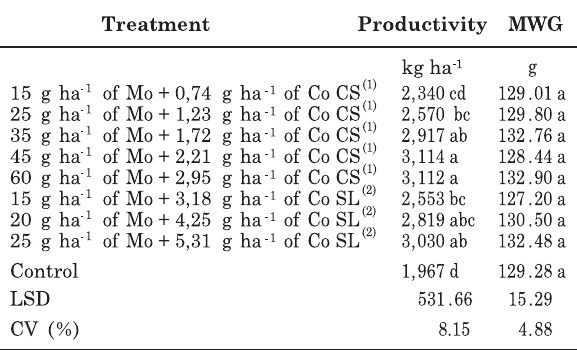
Table 2. Mean yield of soybean and mean weight of 1000 grains (PMG) at different Mo and Co doses